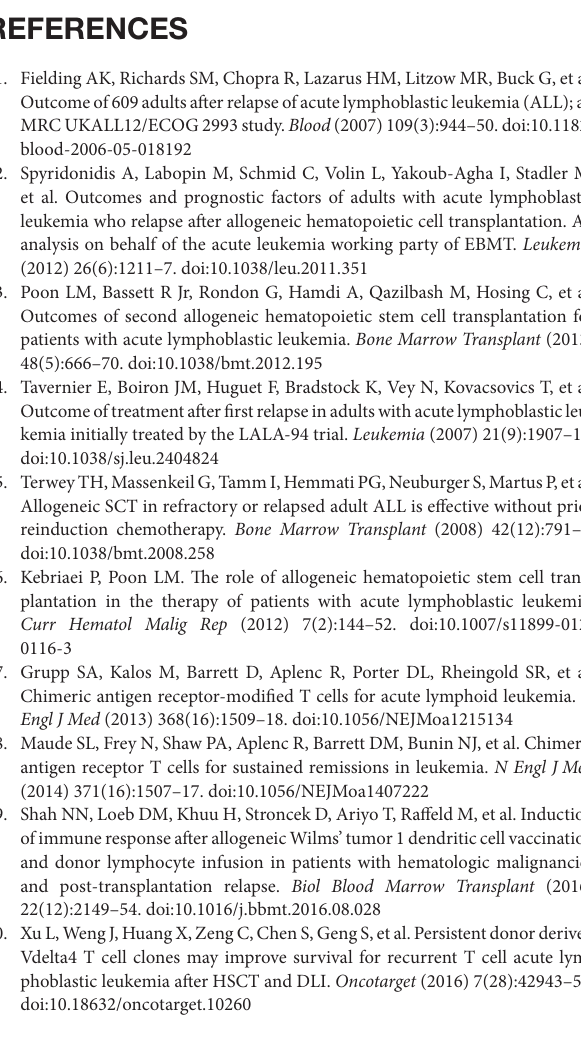
fixed, permeabilized and intracellularly stained with anti-CG antibody. B-ALL cells were differentiated based on light scatter characteristics as well as established surface phenotype (CD10 + /CD16 − /CD19 + /CD38 + ). FigUre s3 | Human leukocyte antigen (HLA)-A*0201 status of UPN2. UPN2 ALL was stained with anti-HLA-A*0201 antibody (clone BB7.2) and analyzed using flow cytometry. Data demonstrate UNP2 to be HLA-A2*0201 negative. The HLA-A*0201-positive cell line, T2, was used as a positive control. FigUre s4 | PMN-associated cathepsin G (CG) is taken up by normal B cells. Flow cytometry detected intracellular CG in the B cell population from normal donor peripheral blood mononuclear cells (PBMC) that were cocultured with irradiated whole PMN at a ratio of 3:1 overnight. PBMC were surface stained with lineage antibodies, including CD3, CD14, CD16, and CD19, and intracellularly stained with anti-CG antibody. B cells were identified based on light scatter characteristics as well as being surface CD3 − /CD14 − /CD16 − /CD19 + . Median fluorescence intensity (MFI) shown represent CG expression within the gated B-cell population. Non-stained and stained normal PMN were used as negative and positive staining controls, respectively. * P < 0.05. FigUre s5 | Raji-A2 cells take up exogenous cathepsin G (CG). Raji-A2 cells were cultured with purified CG (10 µg/mL) for 24 h. Western blot analysis shows uptake of CG by Raji-A2. Western blots demonstrate CG protein in whole-cell lysates from Raji-A2. Gels were loaded with 30 µg of protein. U937 cell line was used as a positive control. Actin was used as a loading